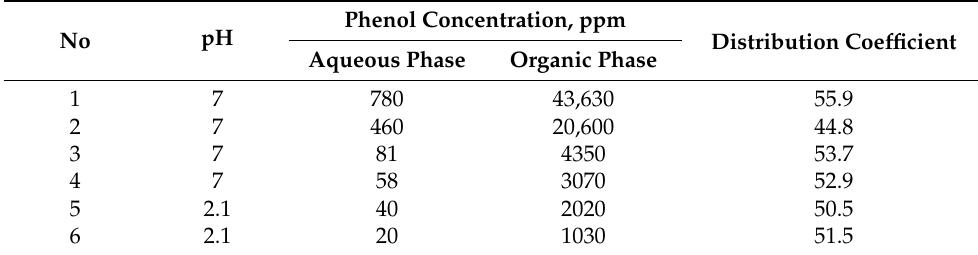
Table 1. Results of phenol extraction with butyl